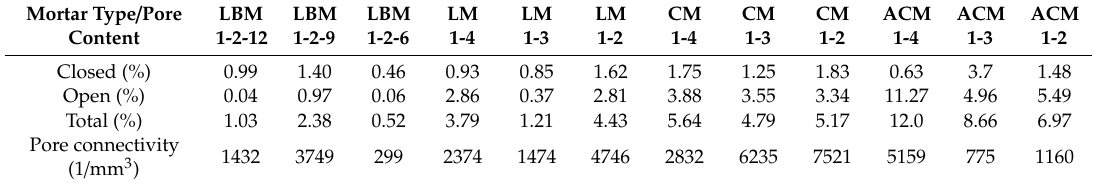
Table5. Theamountofopenandclosedpores, aswellastheirconnectivityobtainedbynanotomography. Mortar Type / Pore